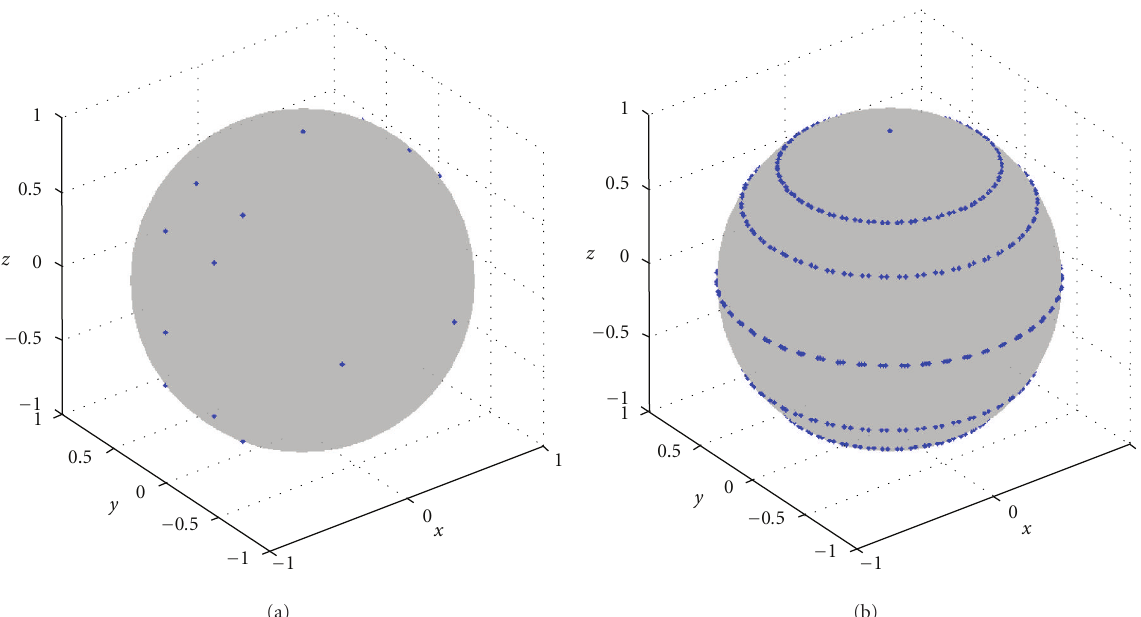
Figure 11: Plane-wave directions of incidence for modes in a 50 MHz band around 750 MHz in a small chamber with dimensions D x = 1m, . 9m, and D . 8m. (a) Without turntable. (b) With turntable rotating around a z -directed axis. Without the turntable, the D y = 0 z = 0 maximum distance between directions of incidence is 48 ◦ and the average distance is 27 ◦ .